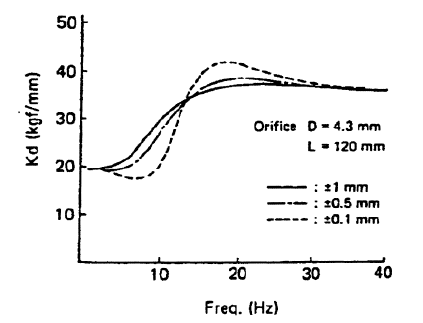
Fig. 4. Dynamic stiffness characteristic of hydraulic mount